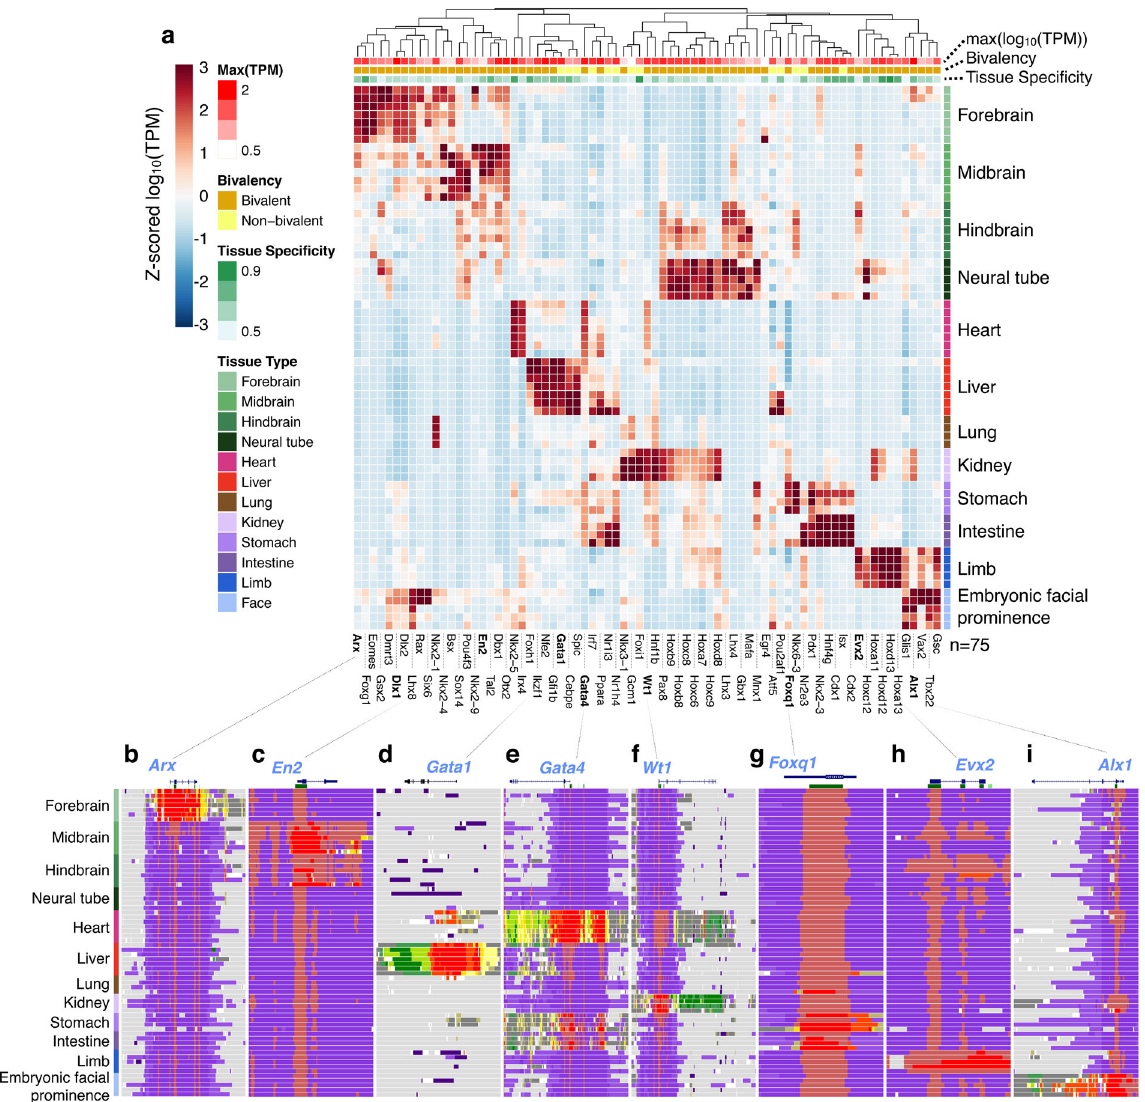
Fig. 4 Expression pro fi les and chromatin states for the transcription factors with the highest tissue speci fi city scores. a Hierarchical clustering of expression pro fi les for the TFs with tissue speci fi city scores >6, with 75 TFs in total. Rows on the top show the maximal expression level across all biosamples (intensities of red), bivalency status (brown for 62 bivalent TFs, and yellow for 13 non-bivalent TFs), and tissue speci fi city score (intensities of green). b – i Example TFs and the chromatin state assignments near their loci. Among these, Gata1 ( d ) is a non-bivalent TF and the rest are bivalent TFs: Arx ( b ), En2 ( c ), Gata4 ( e ), Wt1 ( f ), Foxq1 ( g ), Evx2 ( h ), and Alx1 ( i ). Each gene name is near the 5 ′ -end of the gene, and CpG islands are indicated as green boxes beneath each gene. Chromatin states are colored as in Fig.